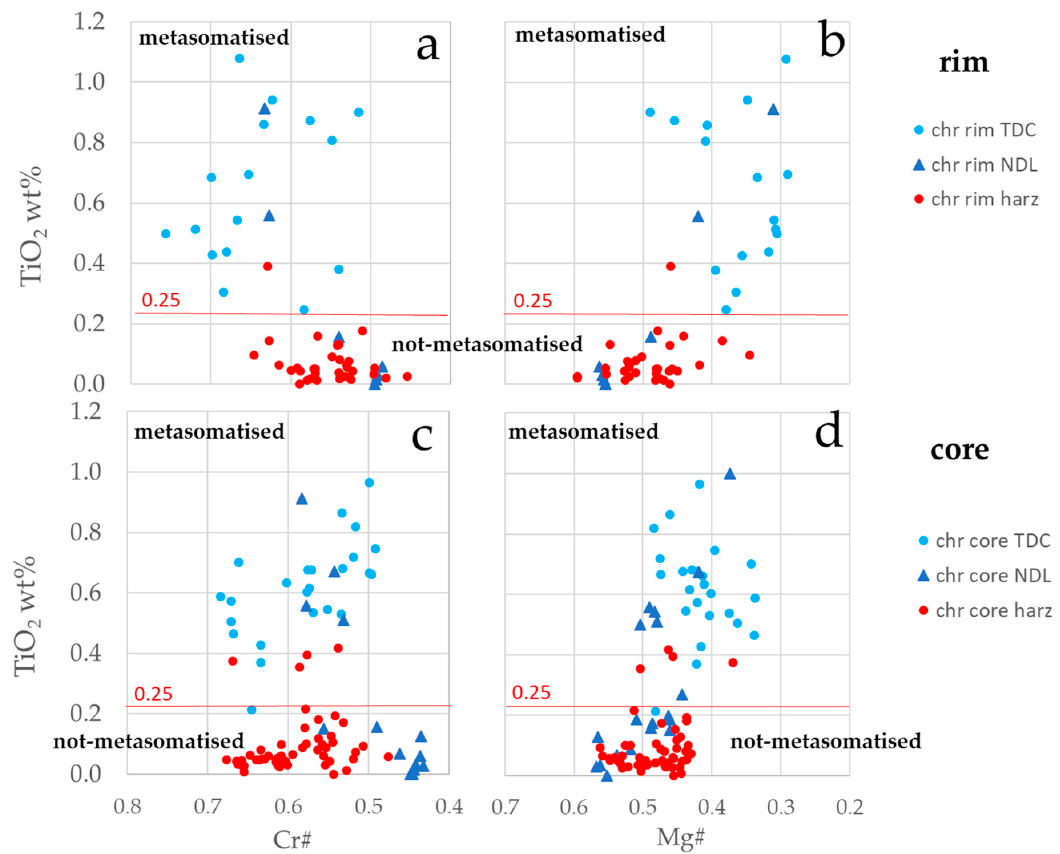
Figure 5. TiO 2 wt. % plotted against Cr# ( a , c ) and Mg# ( b , d ), for rim ( a , b ) and core ( c , d ) in Cr-spinel from analysed rocks. Metasomatised and not-metasomatised Cr-spinel are defined on the basis of TiO 2 wt. % = 0.25 (modified after [29,30] and the references therein).